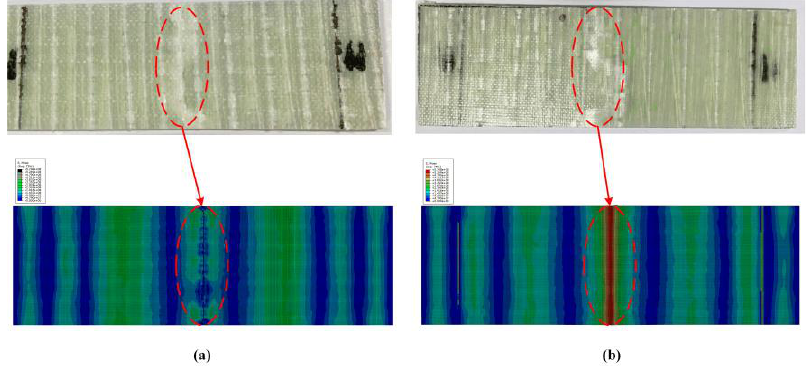
Figure 14. The failure mode of GFRP laminate. ( a ) Compression side, ( b ) Tension side.